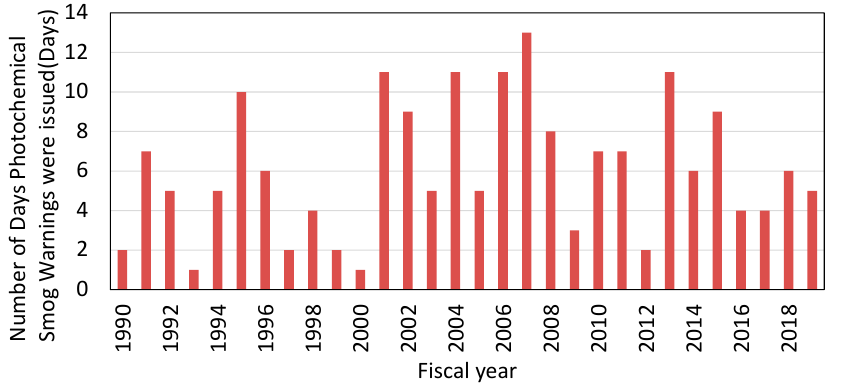
Figure 6. Trend in the number of days on which photochemical smog warnings (PSW) were issued in Kawasaki.